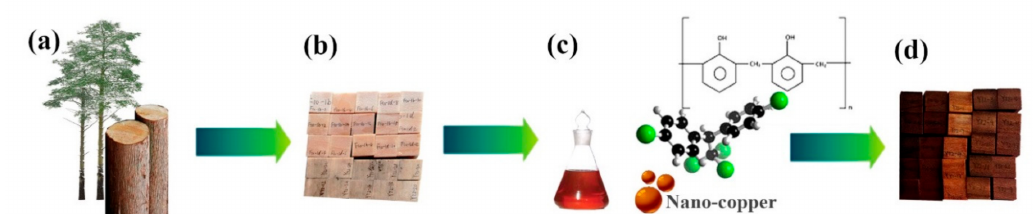
Figure 1. Schematic illustration of the sample preparation. ( a ) Chinese fir logs, ( b ) Sawed samples, ( c ) Preparation of nano-copper modified PF resin, ( d ) Chinese fir samples impregnated with resin.